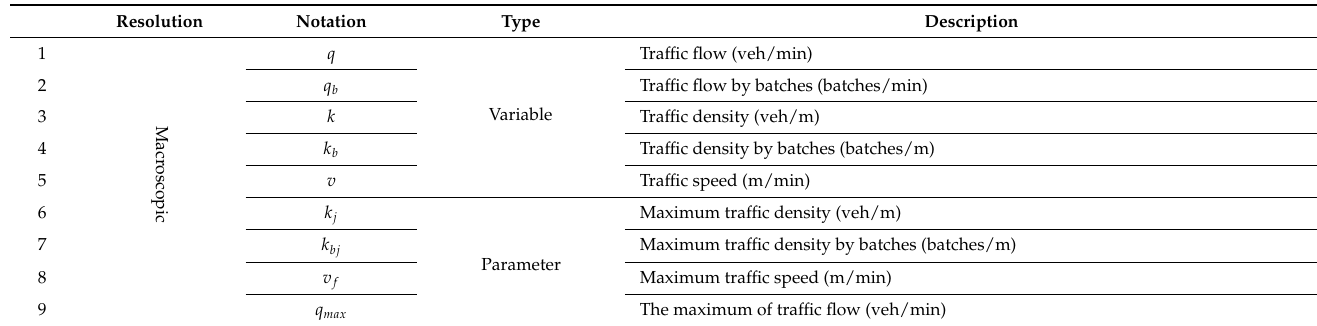
Table 3. Overview of used variables and parameters in the